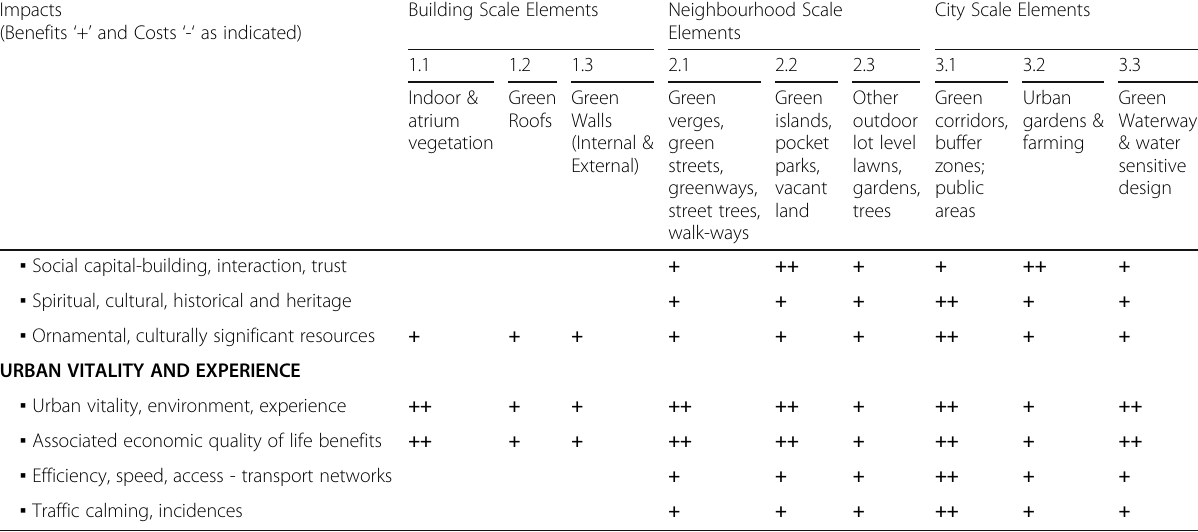
Table 2 The community benefits and costs of urban greening (with a focus upon biophilic urbanism elements) (Continued) Impacts (Benefits ‘ + ’ and Costs ‘ - ‘ as